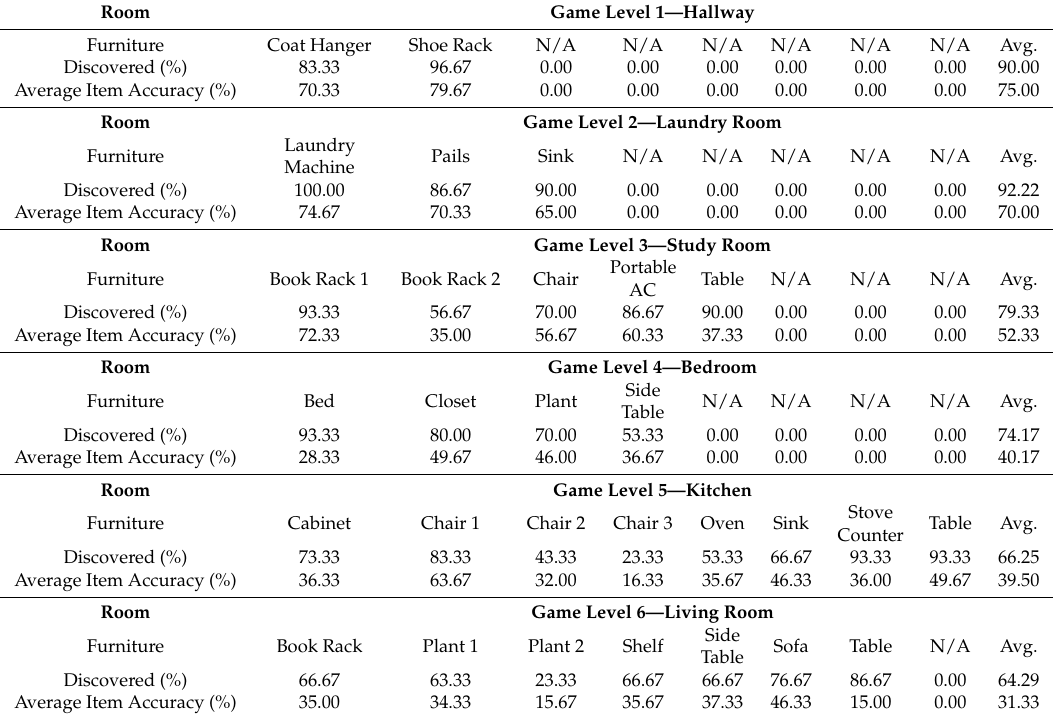
Table 3. Average success rate of wire net test according to room items.